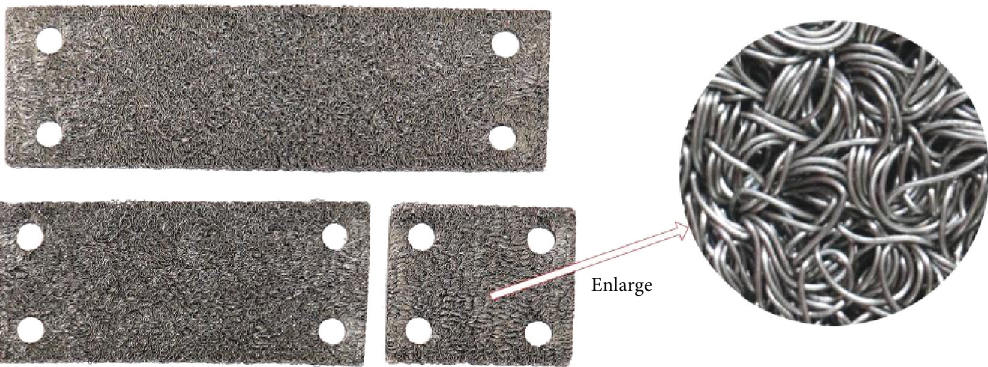
Figure 2: EMWM specimens. Table 1: Formation parameters.